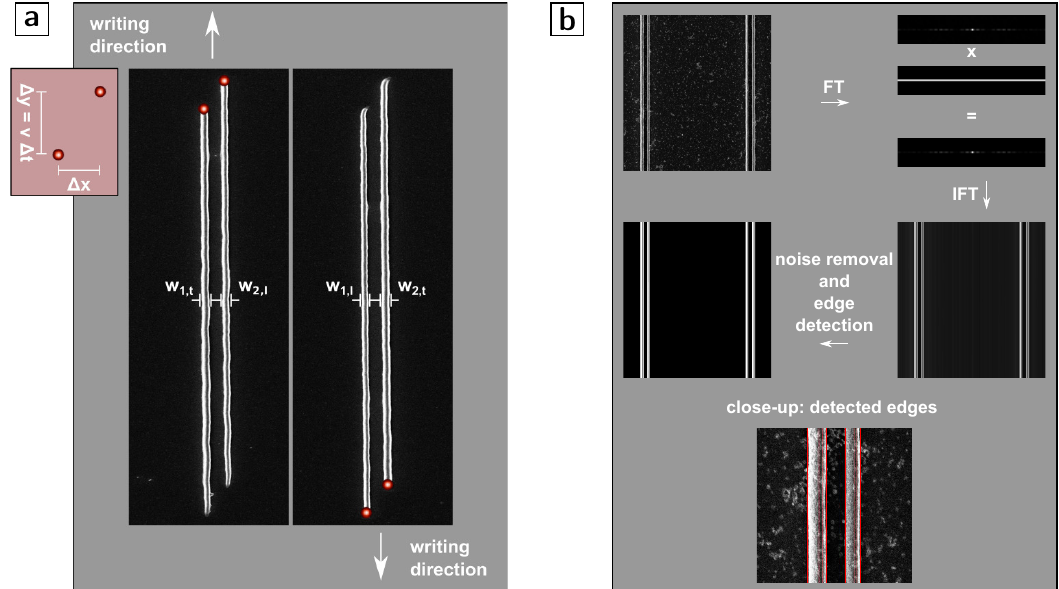
Figure 1. ( a ) Inset: scheme of the arrangement of the two foci. Displacement of the foci orthogonal to the writing direction by ∆ x and along the writing direction by ∆ y . One focus trails the other in time by ∆ t = ∆ y / v with v being the writing speed. Main figure: Exemplary scanning electron micrographs of lines written in alternating writing directions with such a multi foci arrangement (indicated schematically). The linewidths w are defined and labelled according to their relative position (left focus → 1, right focus → 2, trailing along the writing direction → t and leading along the writing direction → l). All linewidths are found by automatic edge detection from micrographs and are individually averaged over a length of several micrometers along the middle of each line (the latter avoids non-steady-state conditions); and ( b ) edge detection method: scanning electron micrographs (pixel size 7 nm ) are Fourier transformed, filtered in the Fourier domain and back